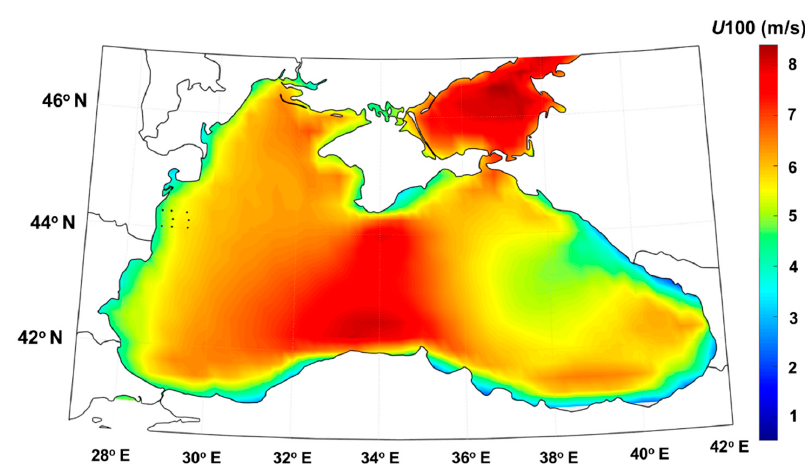
Figure 6. The spatial distribution of the U 100 (m/s) parameter over the Black Sea area. Results computed for the 20-year time interval of 2000–2019.